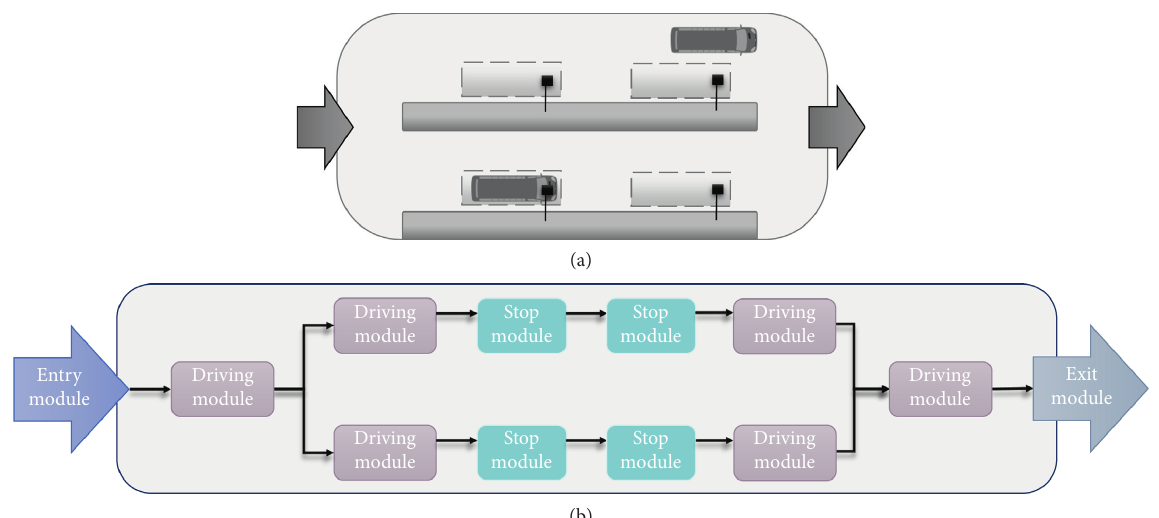
Figure 4: (a) An example terminal with four stops. (b) Flowchart of this terminal constructed from the entry, exit, driving section, and stop modules.